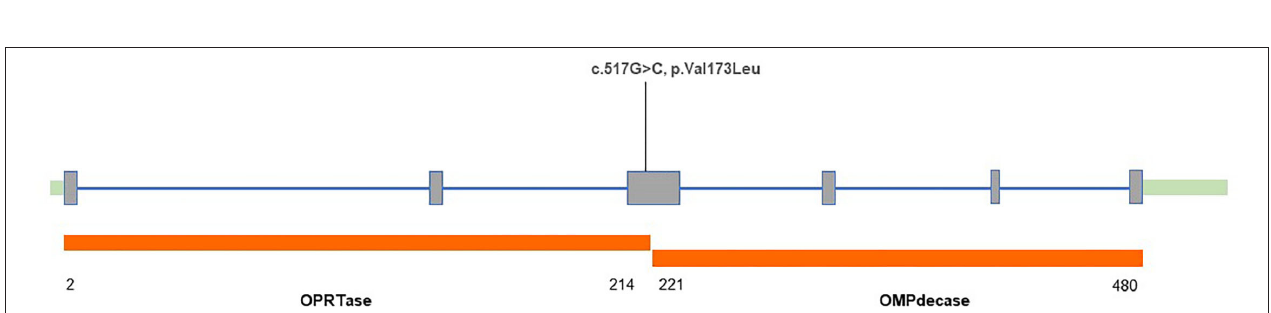
FIGURE 2 | Structure of the human uridine monophosphate synthetase (UMPS ) gene with variant found in our patient.